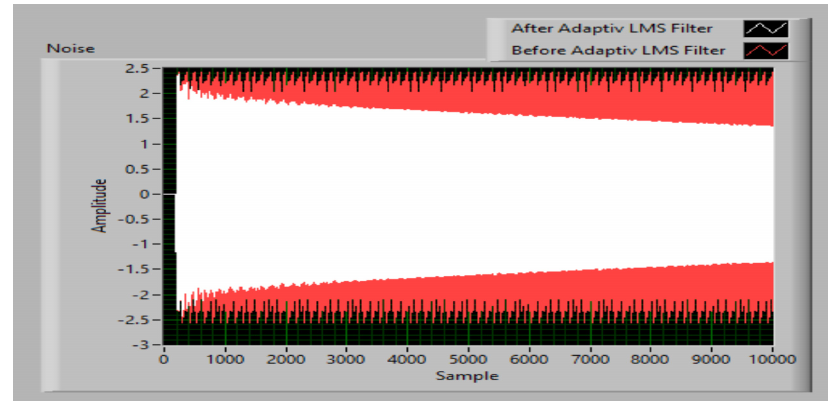
Figure 19. ANC simulation result with optimized LMS algorithm.